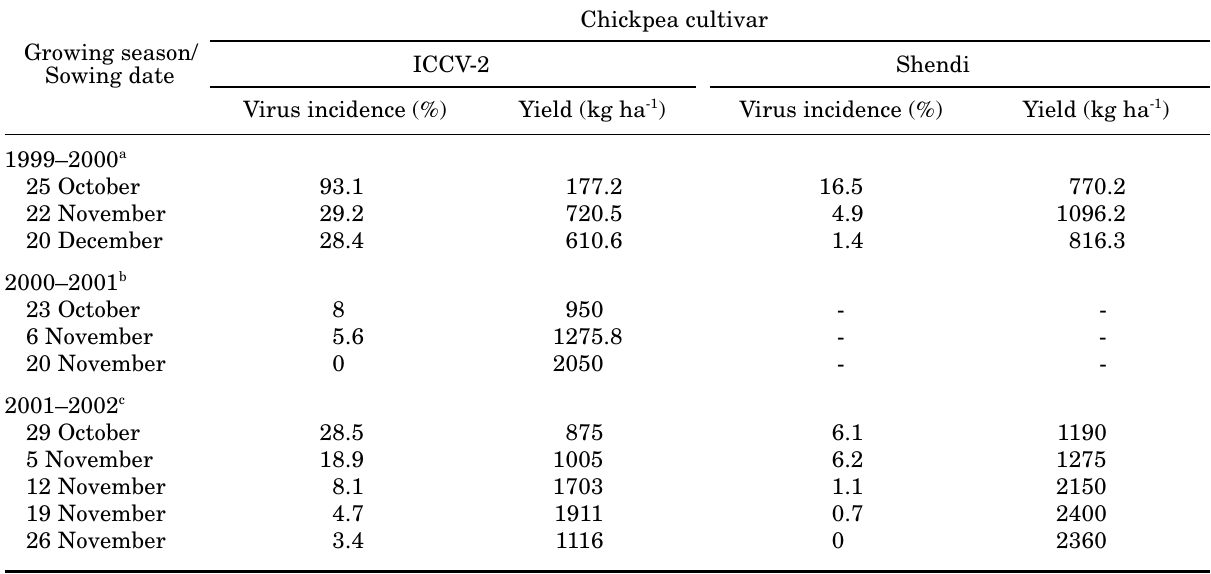
Table 3. Effect of sowing date and cultivar on chickpea stunt incidence and chickpea yield (kg ha -1 ), at Hudeiba, Sudan, during three growing seasons